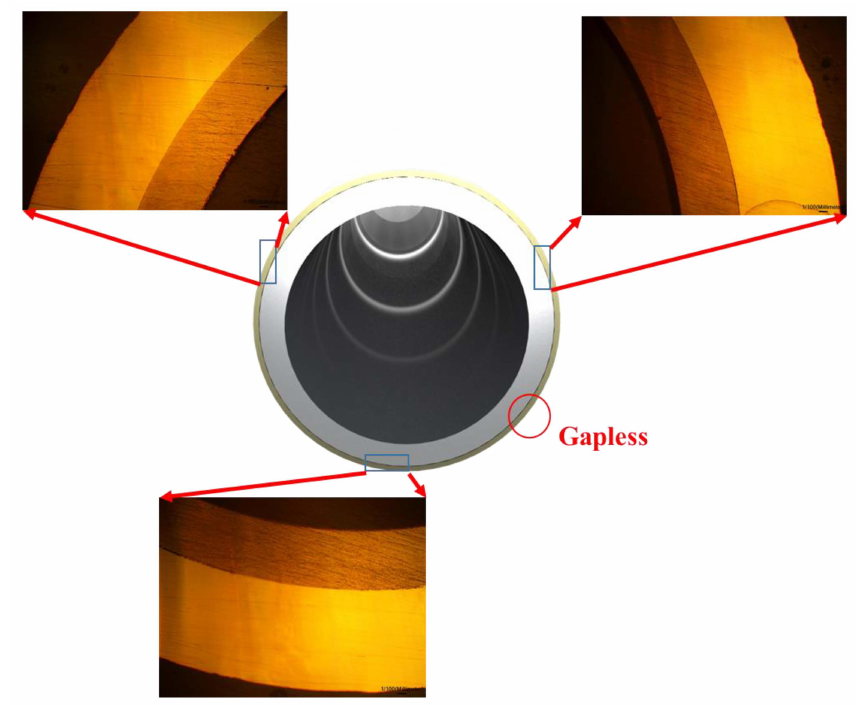
Figure 5. Optical microscopy image of PST without heat treatment. Schematic of the PST manufacturing process by swaging.